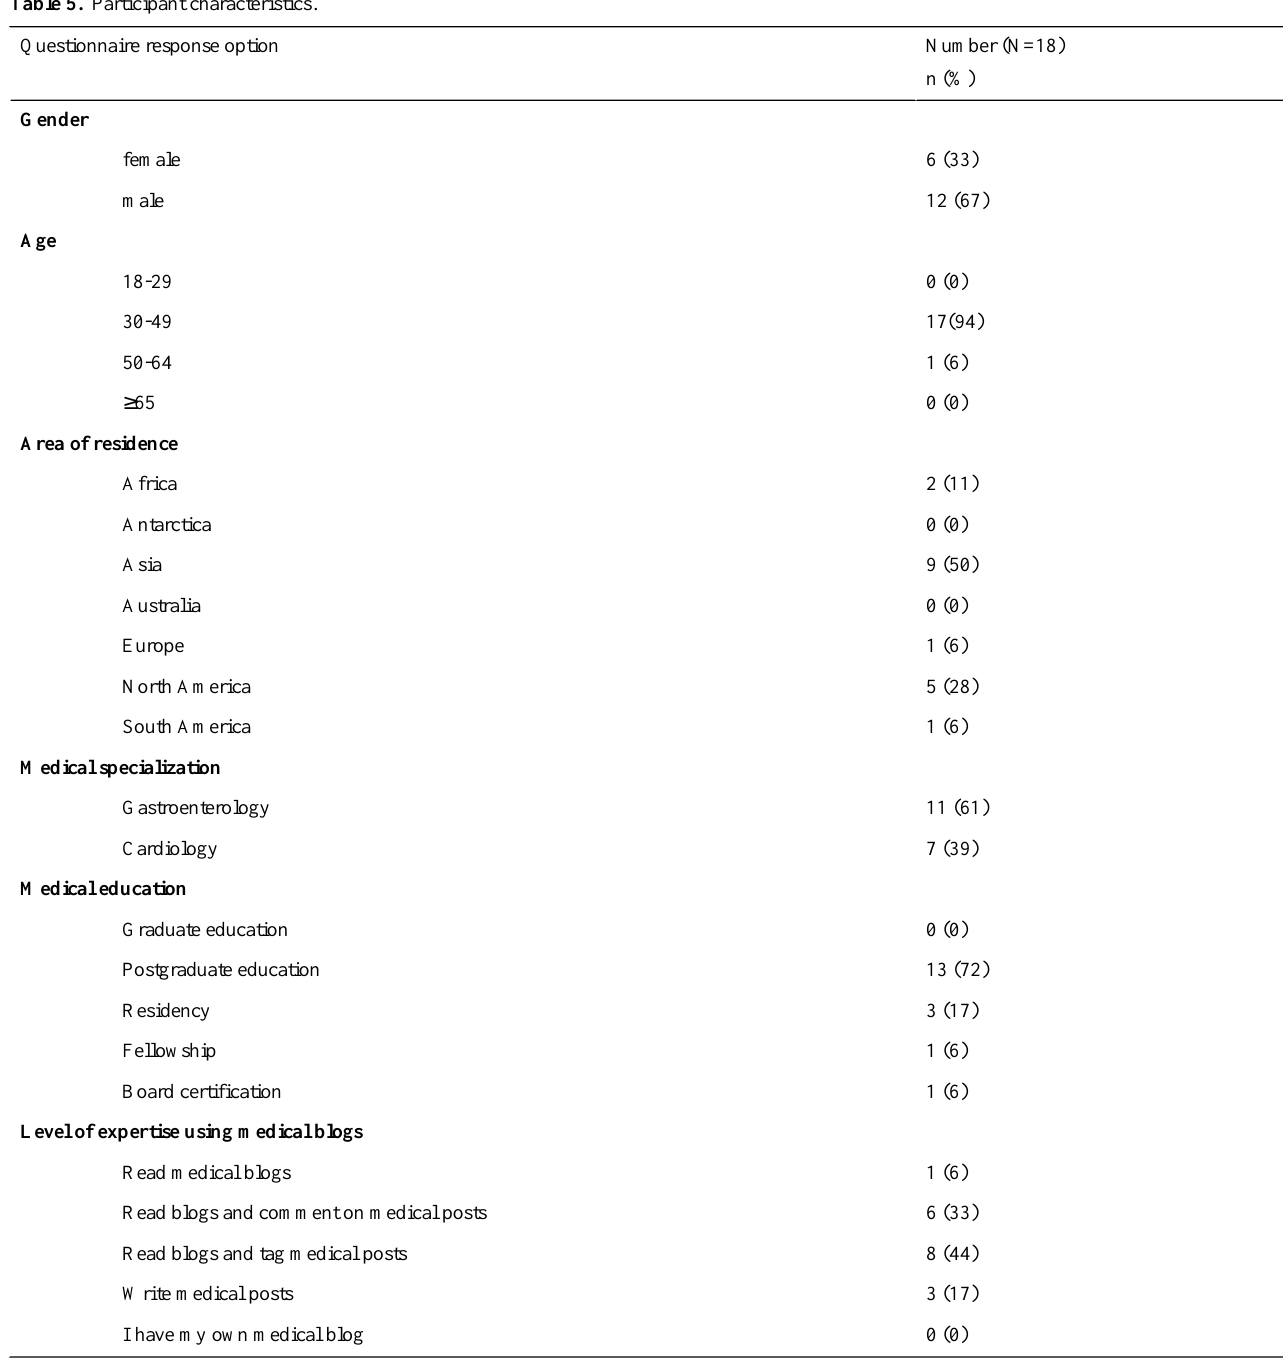
Table 5. Participant